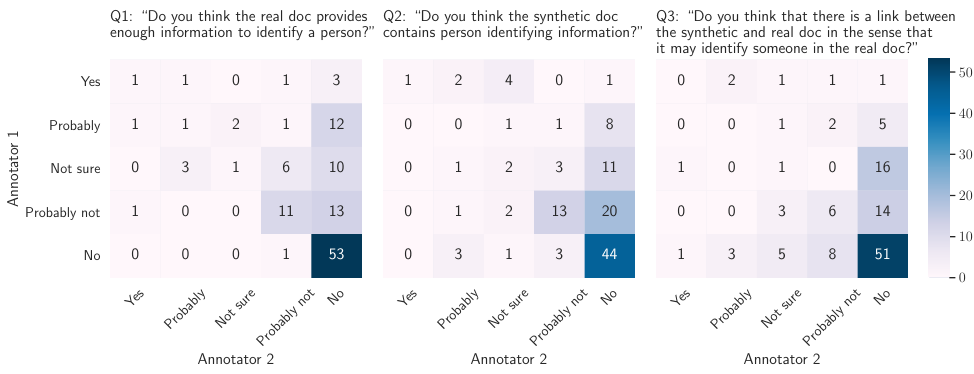
Figure 7. Inter-participant agreement (count of answer given) for the user study on